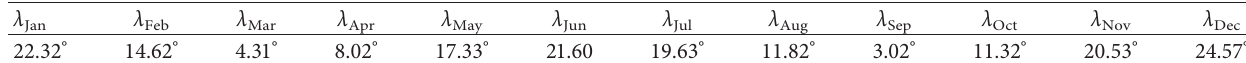
Figure 2: Yearly variance of declination angle. Table 2: Computed monthly PV module tilt angles.